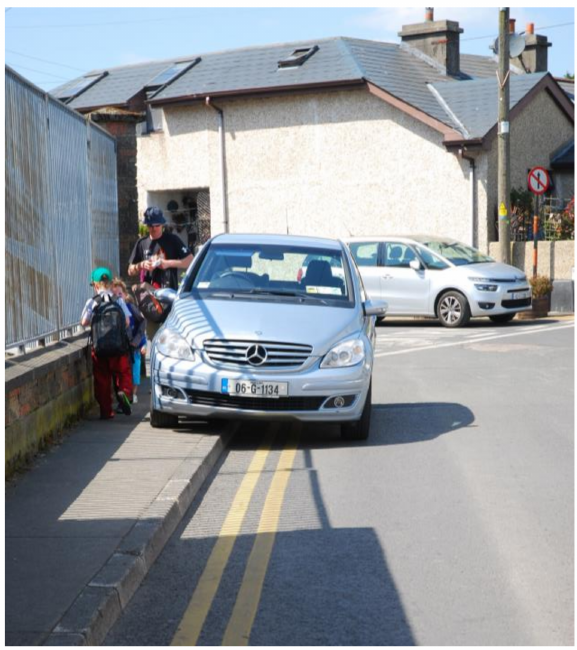
Figure 12. Raleigh Row,